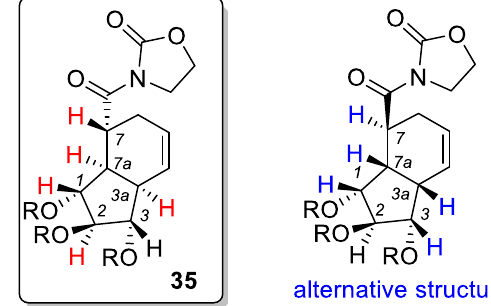
Figure 1. The NOE values of bicyclic product 35.